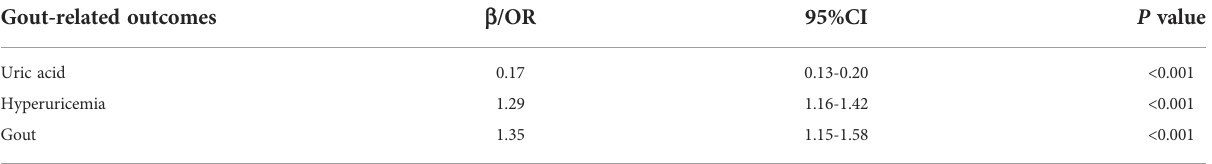
TABLE 5 WQS regression model to assess the adverse association of the mixture of blood metals with gout-related outcomes. Gout-related outcomes